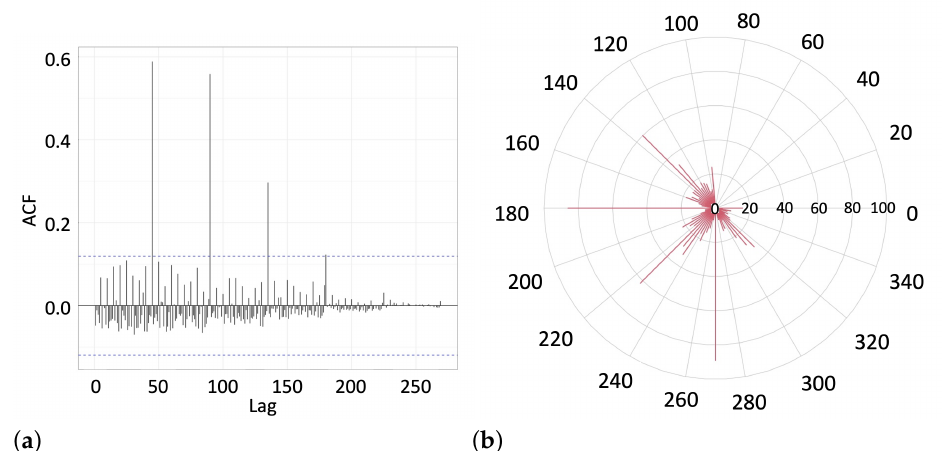
Figure 10. ( a ) The autocorrelation function (10) of the angle lags between the sequential lines observed for the participants of Experiment 2. The dashed horizontal line marks the level of statistically significant correlations. ( b ) The radial histogram (not normalized) of the line-drawing angles observed in Experiment 2.